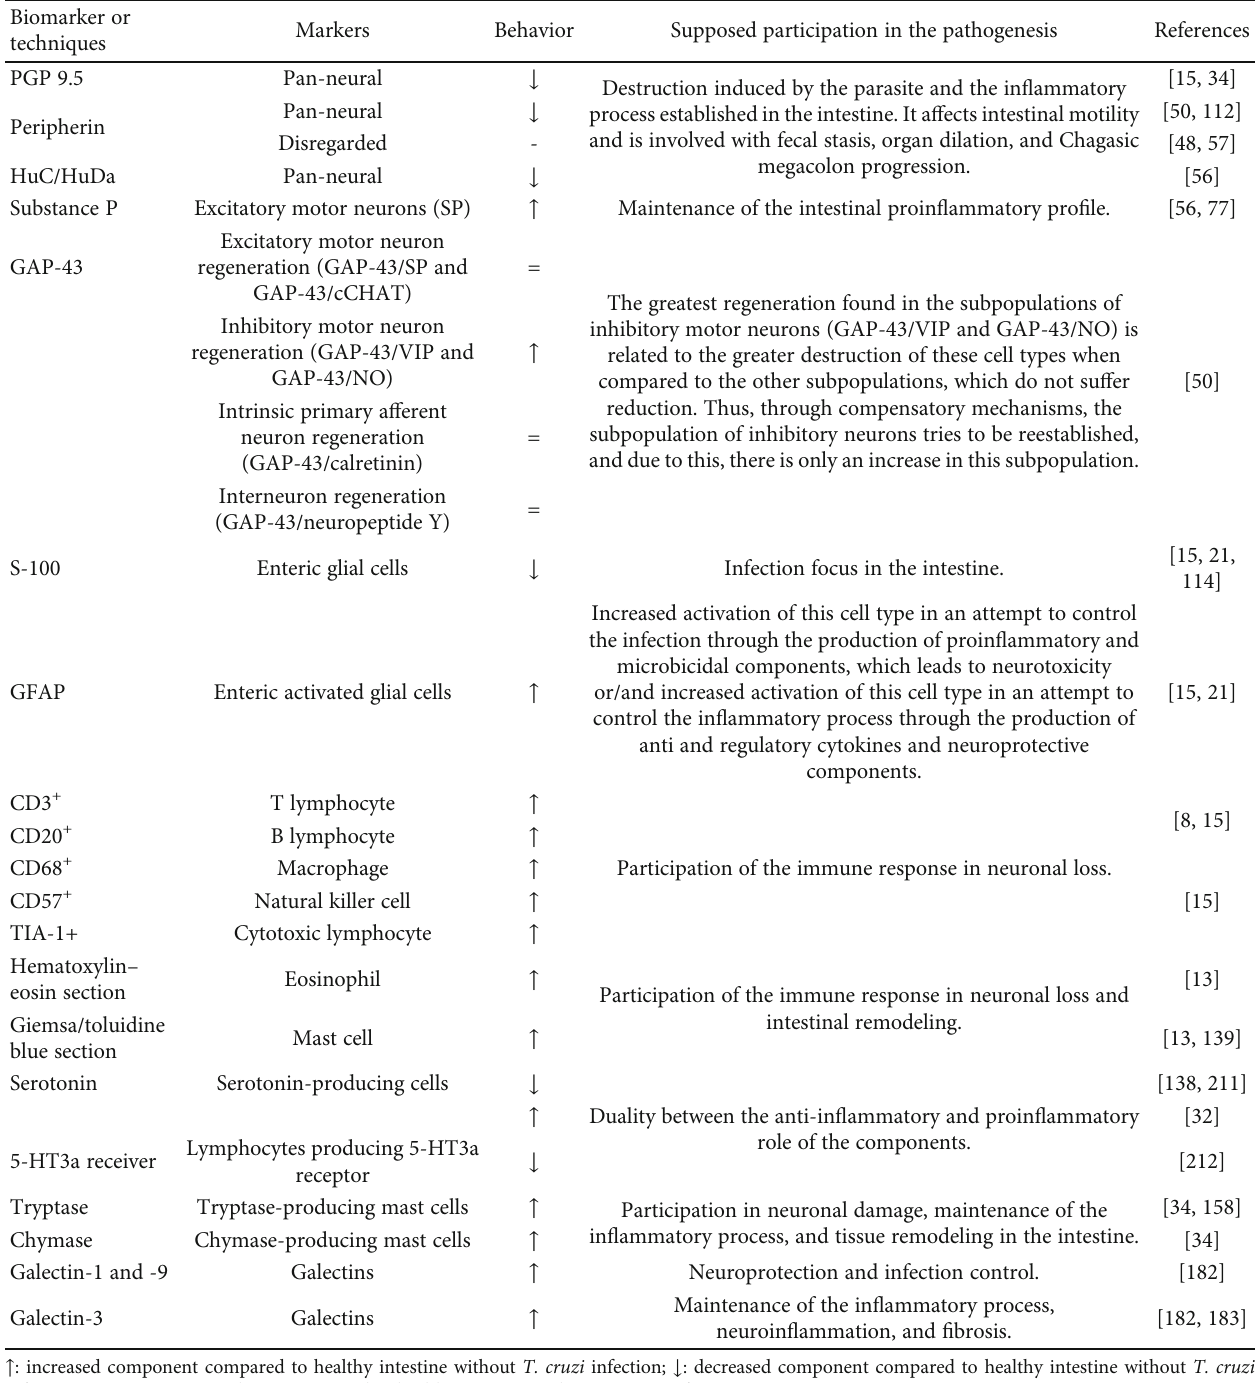
Table 1: Intestinal microenvironment and biological behavior of the components involved in the pathophysiology of Chagasic megacolon. Biomarker